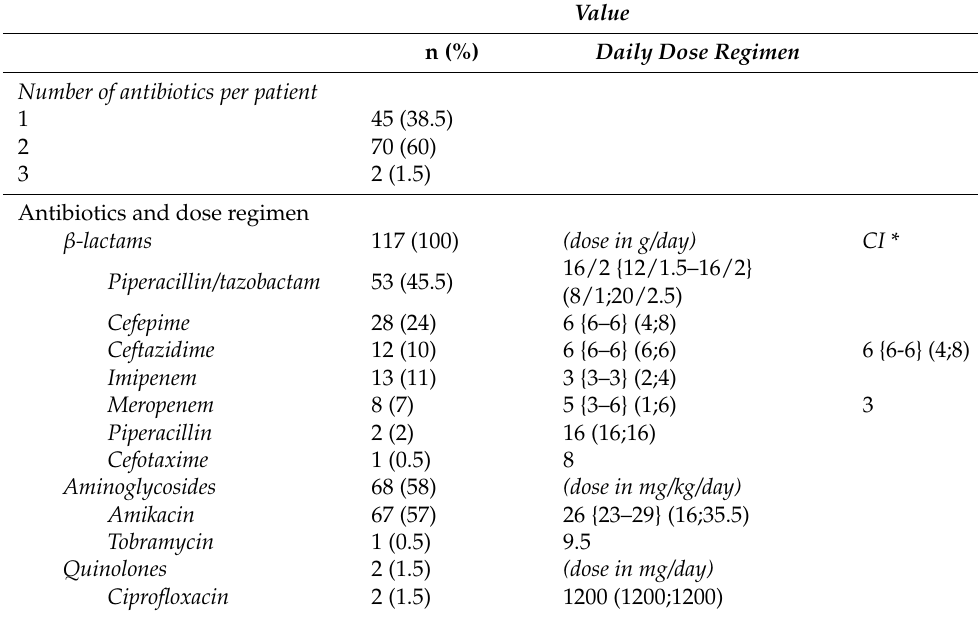
Table 4. Empirical antibiotic therapy and dose